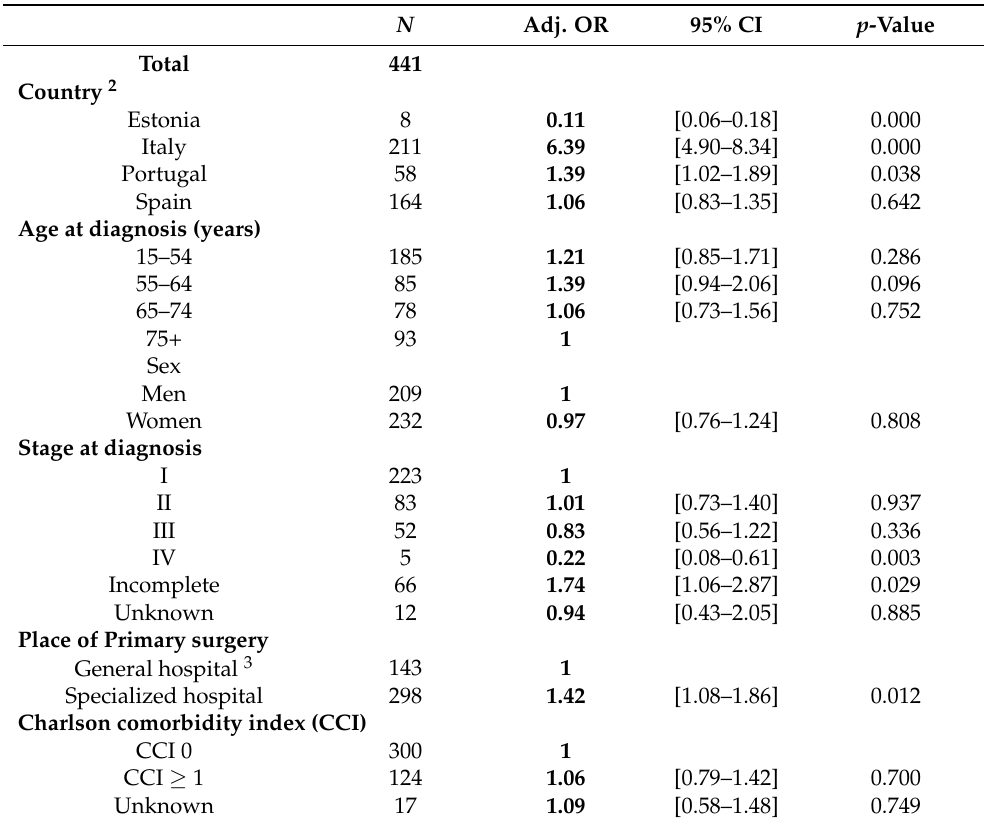
Table 2. Number of cases ( N ) receiving a complete pathological report (PR) with eight recommended histopathological items 1 and adjusted Odds Ratios (OR) with 95% Confidence Intervals (CI), for cutaneous melanoma patients diagnosed in 2009–2013 in four European